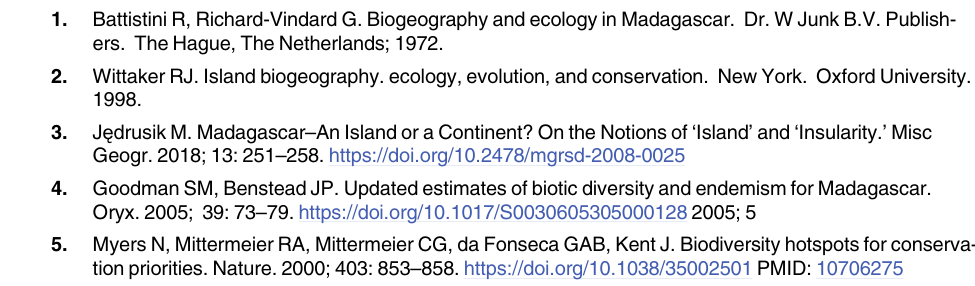
S2 Table. Dorsal skull landmarks. Descriptions and types of the 27 landmarks used for the dorsal view. S3 Table. Ventral skull landmarks. Descriptions and types of the 42 landmarks used for the ventral